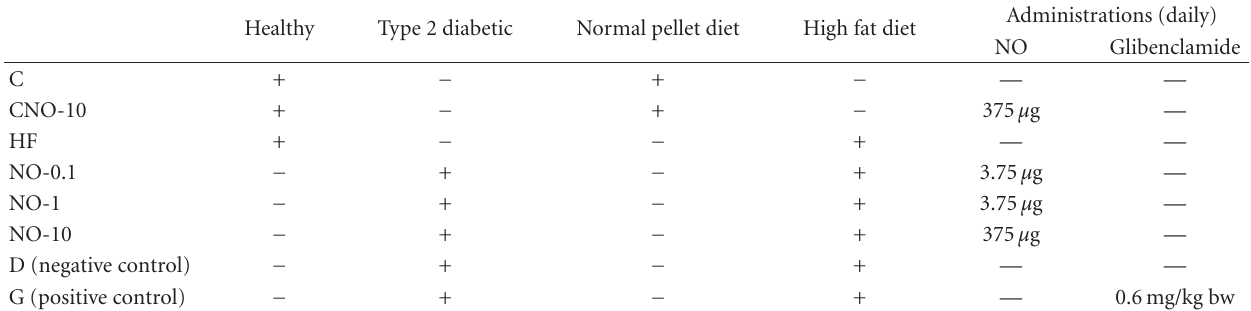
Table 2: The implementation of experimental groups according to diets and administrations applied to animals. ∗